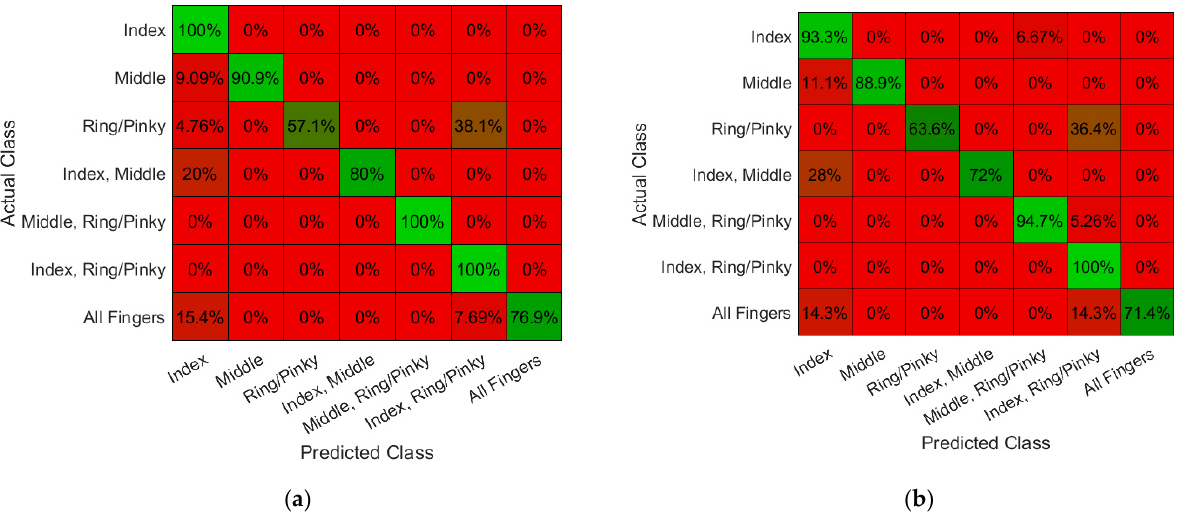
Figure 9. Online Classification performance and the associated confusion matrices of the trained models for finger gesture detection: ( a ) Online Classification with Unwashed EMG Textile Sleeve; ( b ) Online Classification with 30× Washed EMG Textile Sleeve.